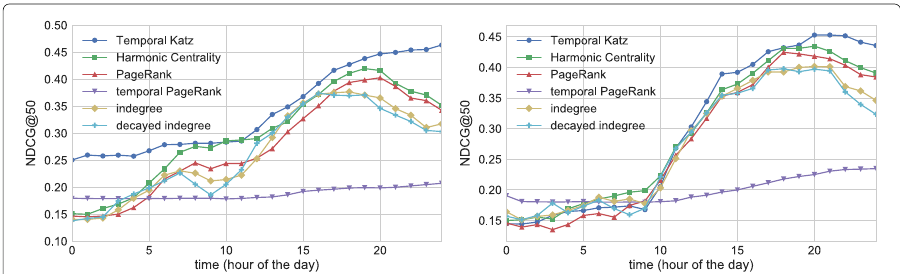
Fig. 14 Overall best daily NDCG@50 performance of temporal Katz centrality and the baselines. Left: UO17, Right: RG17